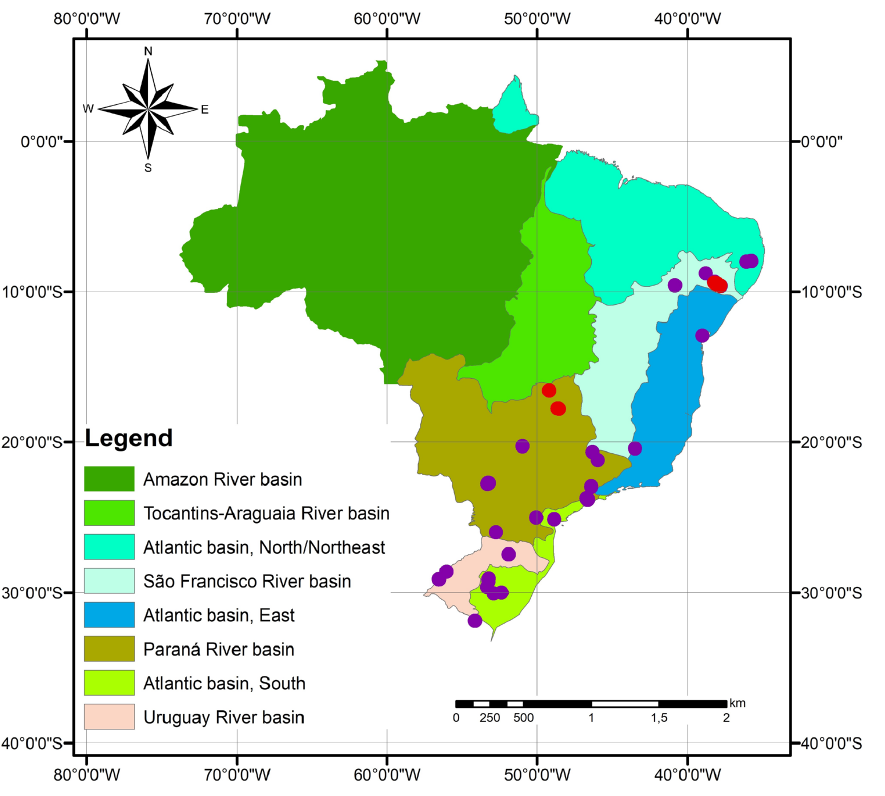
Figure 11. Occurrence of Ceratium furcoides in Brazilian aquatic systems, showing previous records (purple dots) and new records from central-western Brazil and the northeast (red dots).